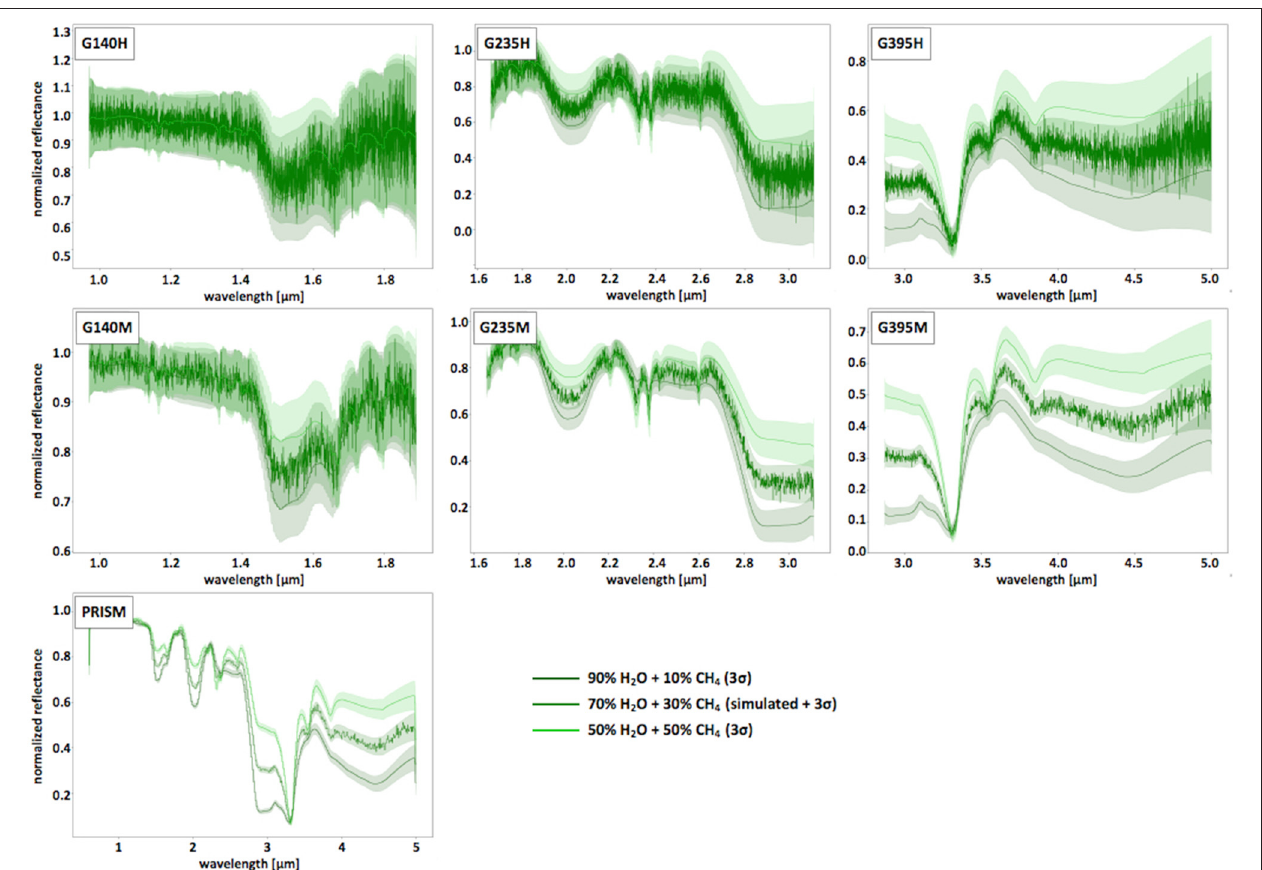
FIGURE 3 | Simulated spectra for two mixtures of water and methane ice, shown (from top to bottom) for the high-, medium- and low-spectral resolution elements, respectively. The simulated signal is show for one mixture for clarity. Shaded areas shown the 3- σ detection limits corresponding to the simulated signal-to-noise ratios. Exposure time and other relevant instrumental features may be found in Table 2